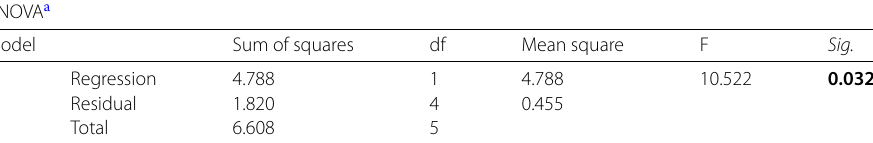
Table 11 ANOVA table of the physical and mechanical properties of total porosity-open porosity ANOVA a Model Sum of squares df Mean square F